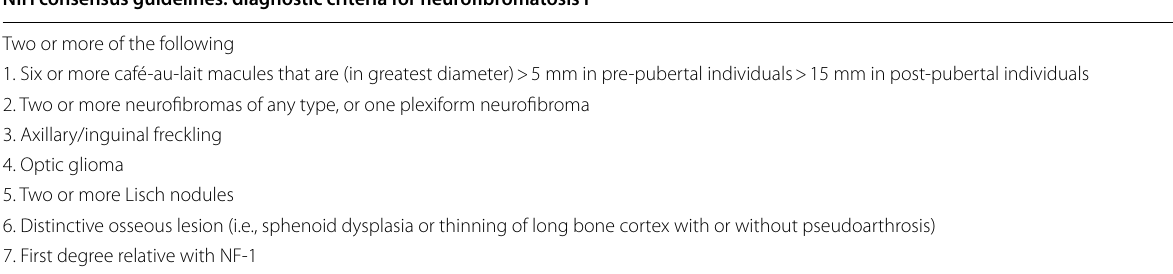
Table 1 NIH consensus guidelines NIH consensus guidelines: diagnostic criteria for neurofibromatosis